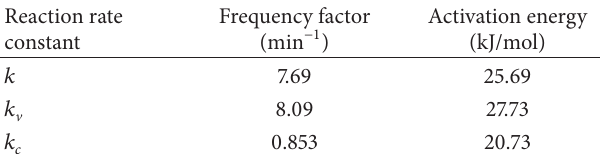
Table 2: Calculated activation energies and frequency factors as per Arrhenius law.